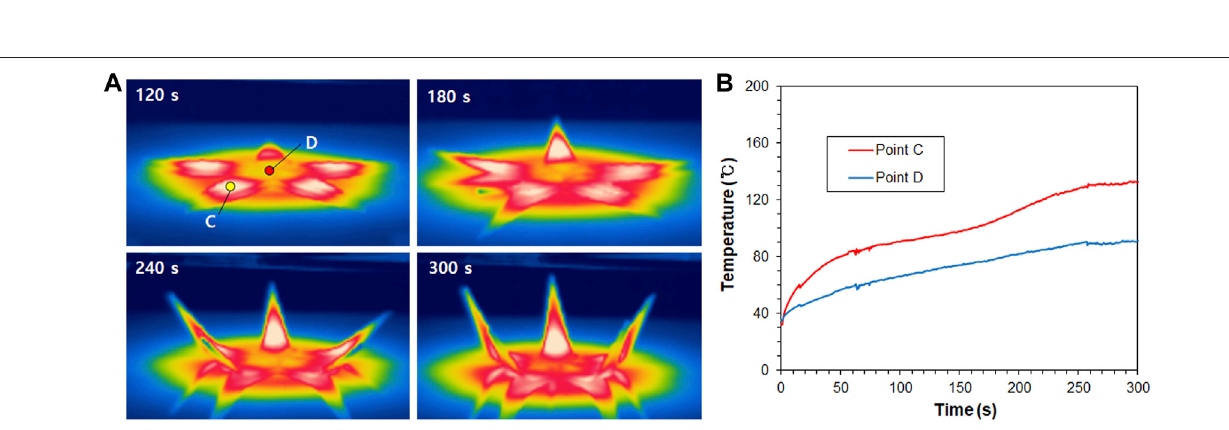
Frontiers in Materials |